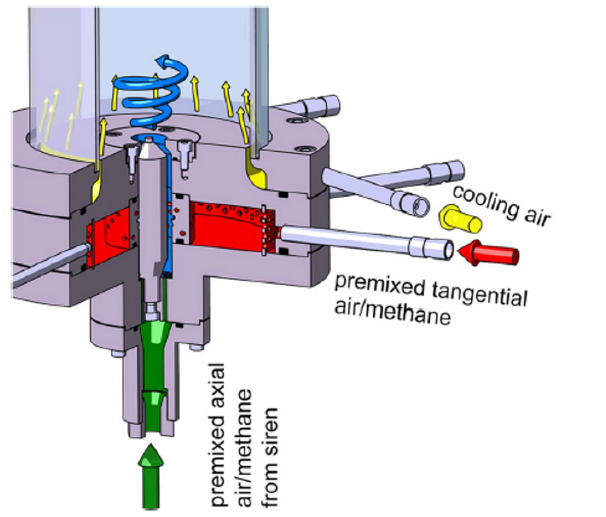
Figure 1. Schematic burner